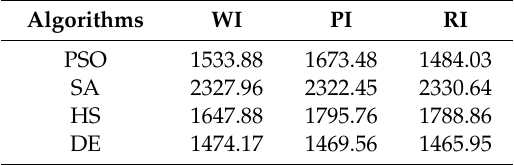
Table 7. Average computational time (s) for di ff erent initialization approaches without ELM-AE.